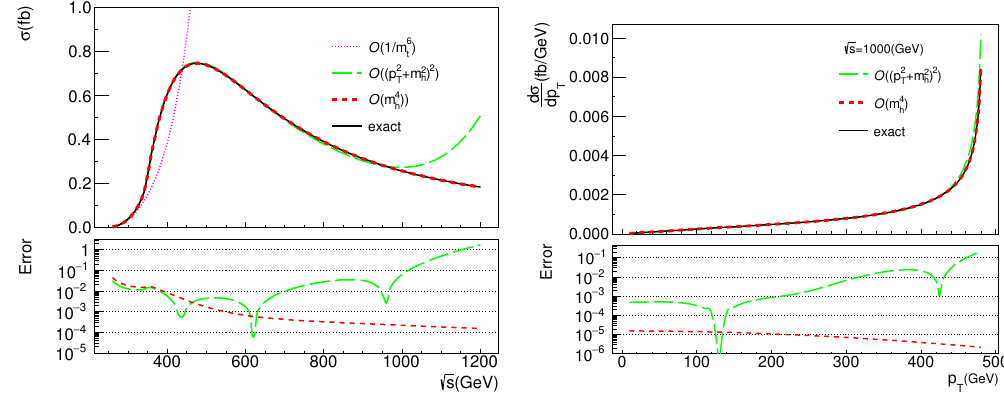
p s . Right side: the transverse p s = 1000 GeV.